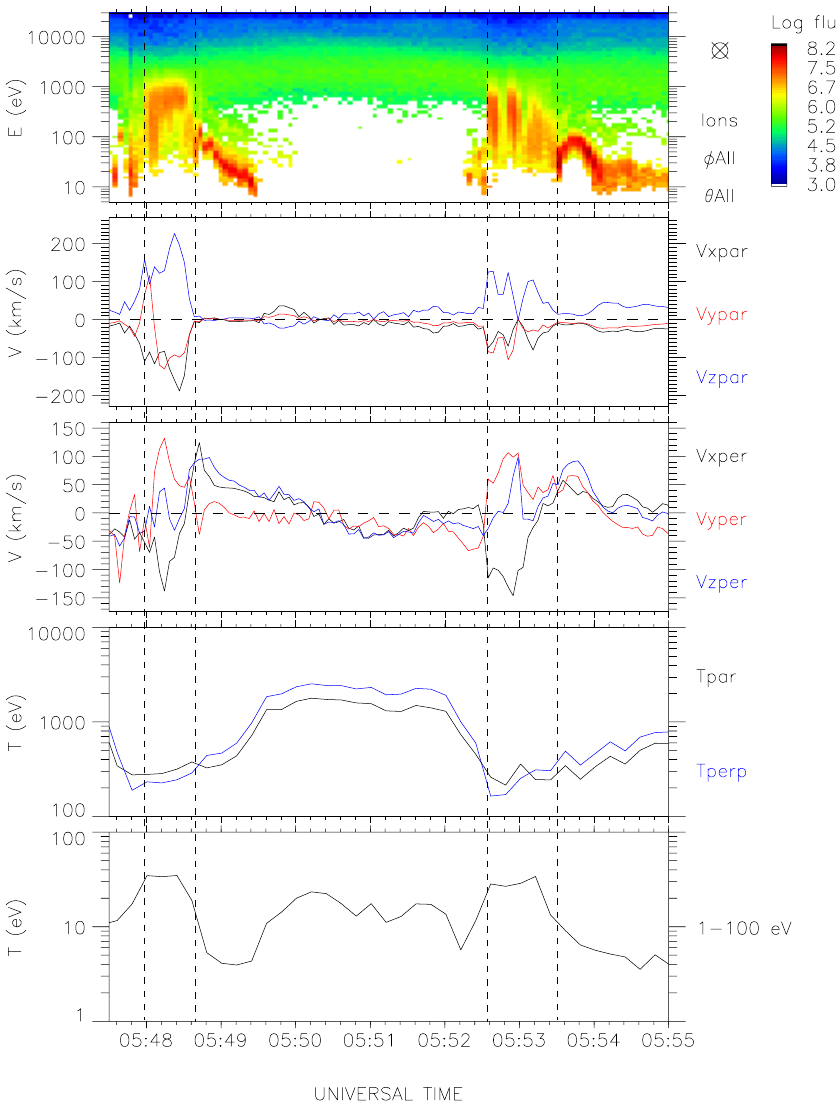
Fig. 6. Detailed moment computa- tions for the period from 05:47:30 to 05:55:00UT on 31 January 2001. The top panel gives the 1D energy-time spectrogram obtained with a time res- olution of 4s (all viewing directions are averaged on board). The second and third panels give the three GSE compo- nents of the ion bulk velocity parallel and perpendicular to the local magnetic field. The fourth panel displays the ion parallel and perpendicular temperatures computed in the full energy range. The last panel gives the average ion temper- ature computed from 5eV to